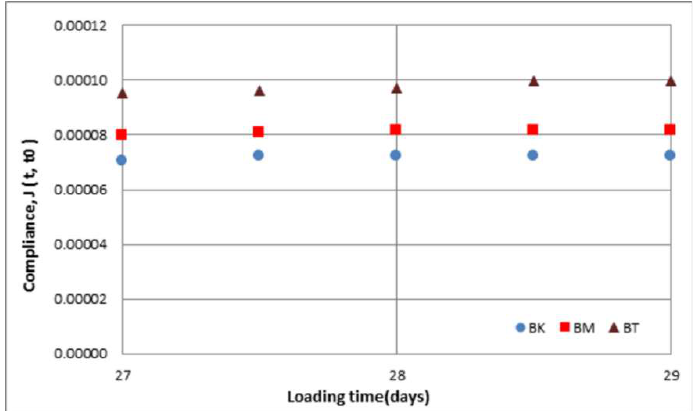
Figure 9. Compliance function 𝐽 ( 𝑡,𝑡 (cid:2868) ) at 27–29 days of loading.